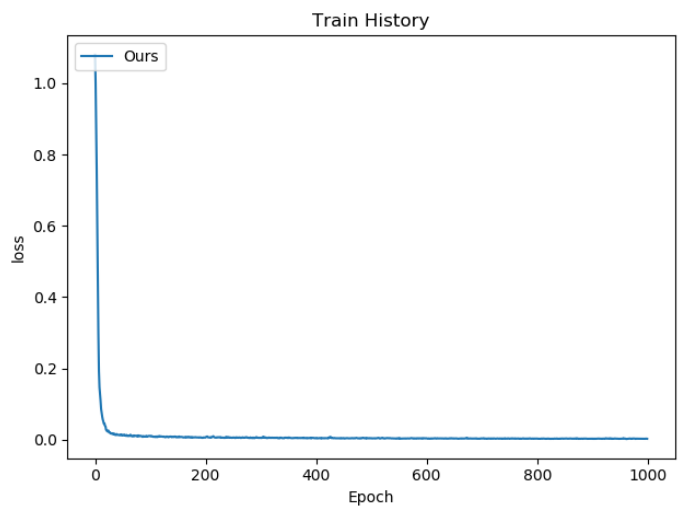
Figure 7. Convergence curve of the proposed PGPM.